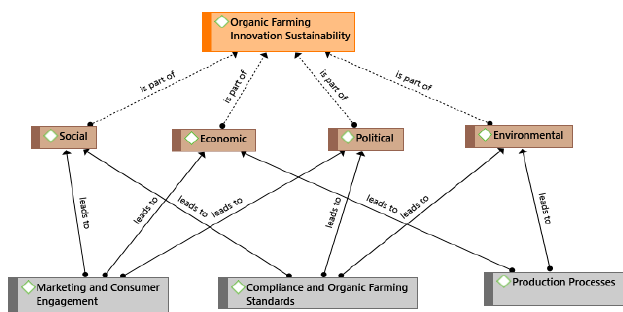
Figure 1: Organic Farming Innovation Sustainability. Source: Atlas Ti